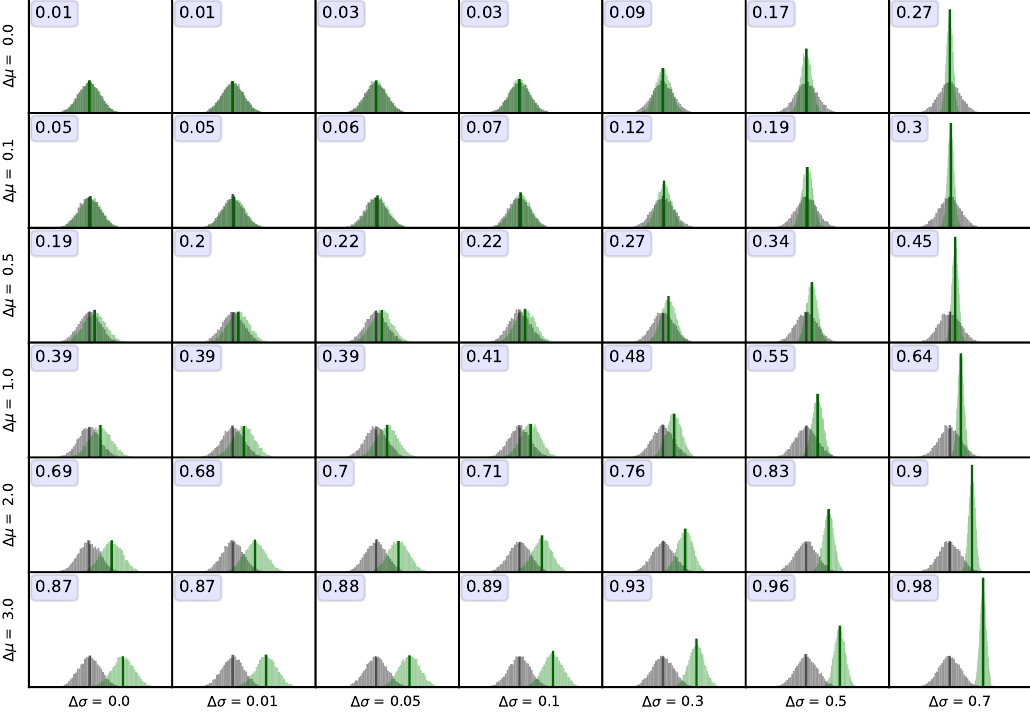
= 0 and standard devia- 0 = ∆ µ and standard deviation σ = σ − ∆ σ 1 1 0